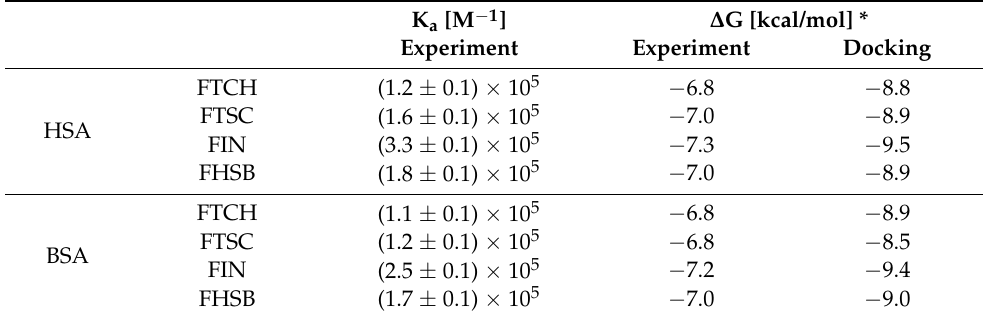
Table 4. Binding constant and Gibbs Energy for FTCH, FTSC, FIN, and FHSB to HSA and